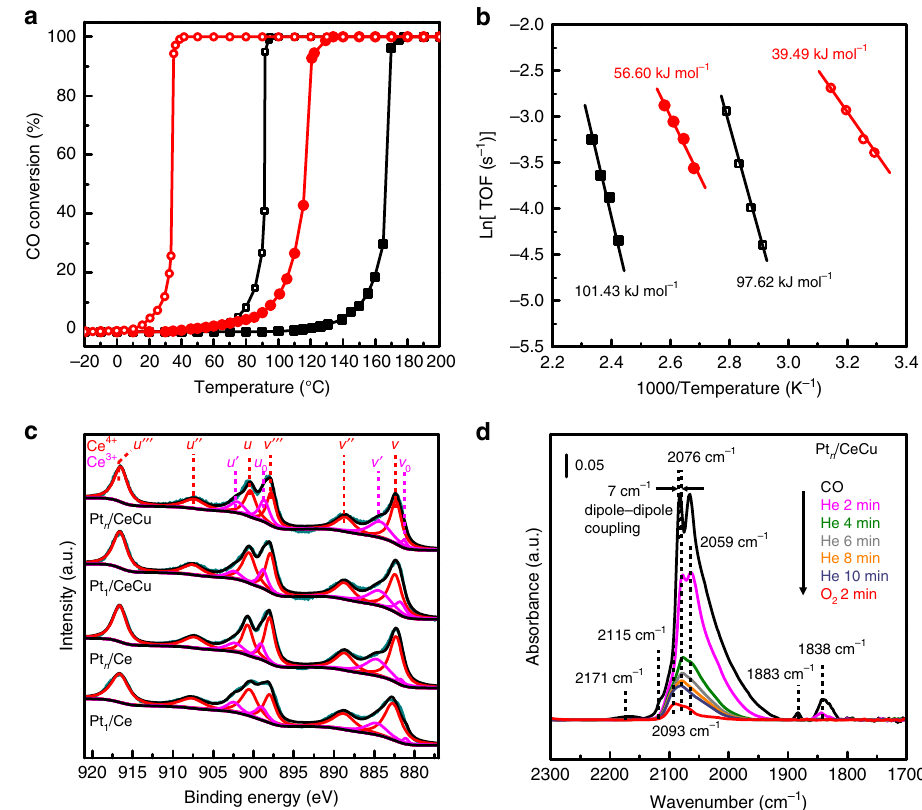
Fig. 2 Catalytic properties and surface activities characterizations of catalysts. a CO conversion and ( b ) reaction rates of catalysts as a function of reaction temperature. The catalysts are Pt 1 /Ce (black fi lled square), Pt n /Ce (black square), Pt 1 /CeCu (red fi lled circle) and Pt n /CeCu (red circle). c Ce 3 d XPS spectra of Pt 1 /Ce, Pt n /Ce, Pt 1 /CeCu and Pt n /CeCu. d In situ DRIFTS spectra of CO adsorption and oxidation of Pt n /CeCu. After CO exposure, He fl ow is continued and the spectra is recorded at 2, 4, 6, 8, 10 min. Subsequently, the fl ow is switched to 1% vol. O 2 balanced by N 2 and the spectrum is recorded at 2 min. Source data are provided as a Source Data fi